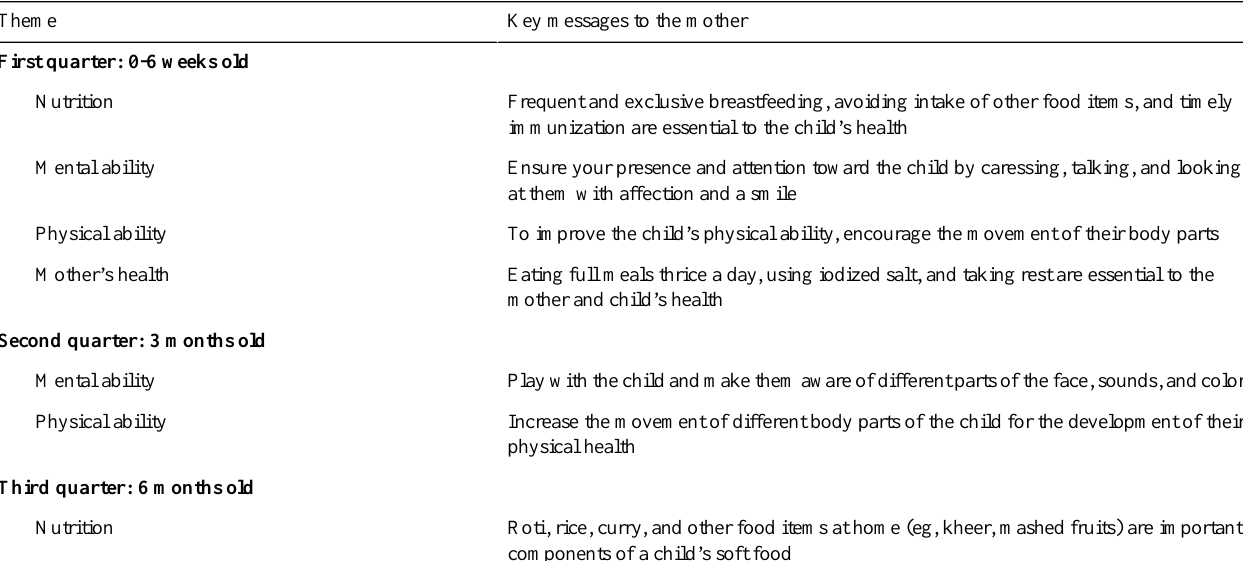
Key messages to the motherTheme Frequent and exclusive breastfeeding, avoiding intake of other food items, and timely immunization are essential to the child’s